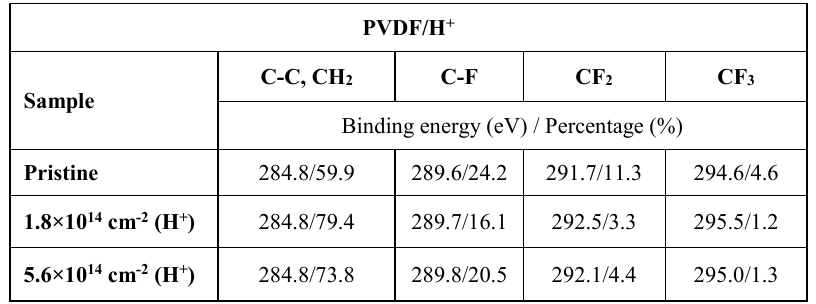
Table 6. Position and abundance of the individual components of the C 1s peak in pristine and H-ion irradiated PVDF nanofibers